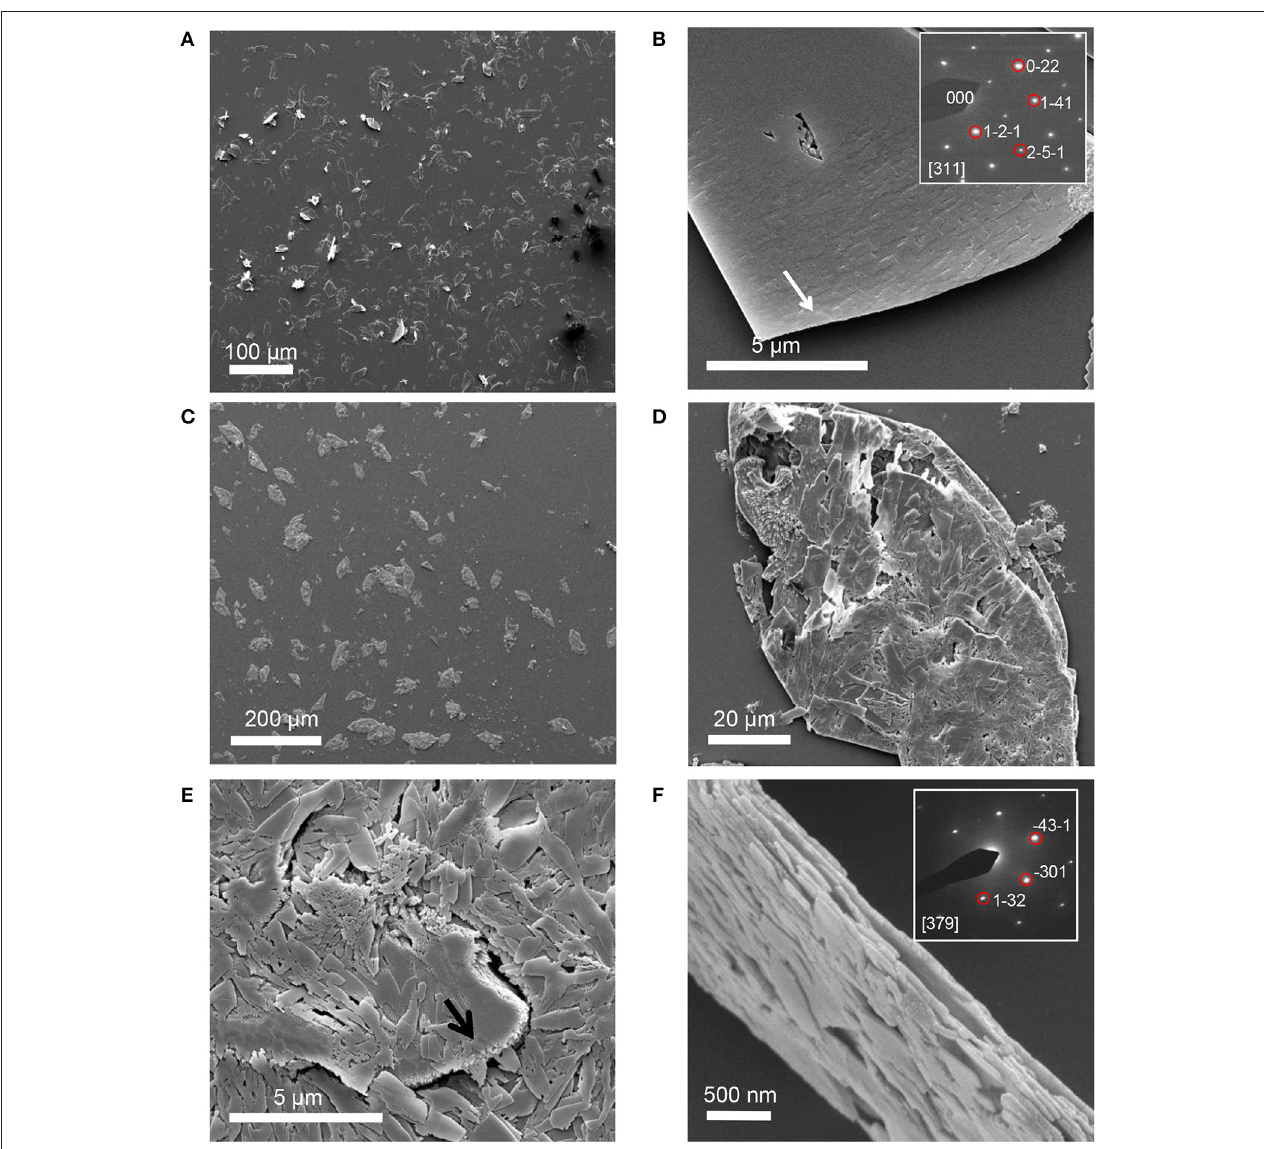
FIGURE 3 | SE images of mineral grown on an STNA15-ELP coated substrate at 3 h (A,B) and 8 days (C–F) . Single crystal platelets dominate the surface at 3 h with the SAED pattern of brushite, inset of (B) . The platelets are polycrystalline FAp at 8 days of incubation. SAED pattern of one of the crystals from the platelet, inset of (F) .